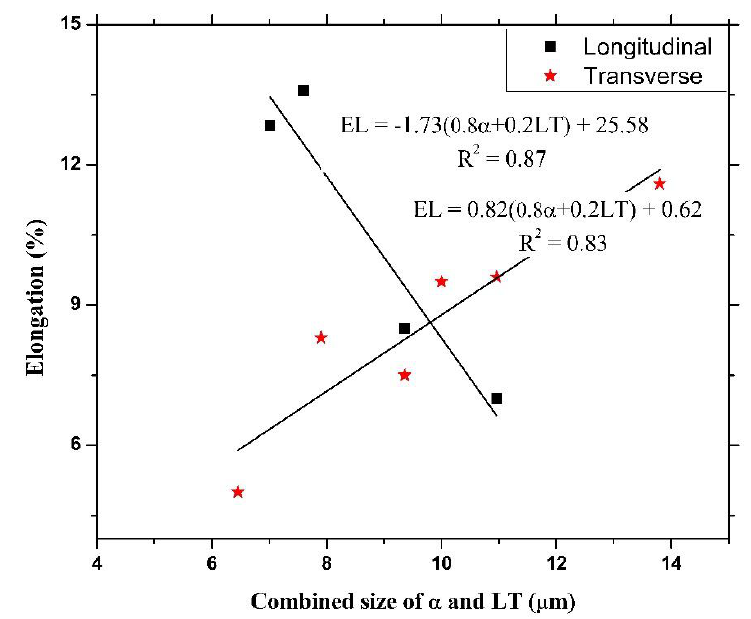
Figure 6. Plot between percentage elongation and combined α lath and powder layer thickness (LT) using rule of mixture for heat-treated samples.